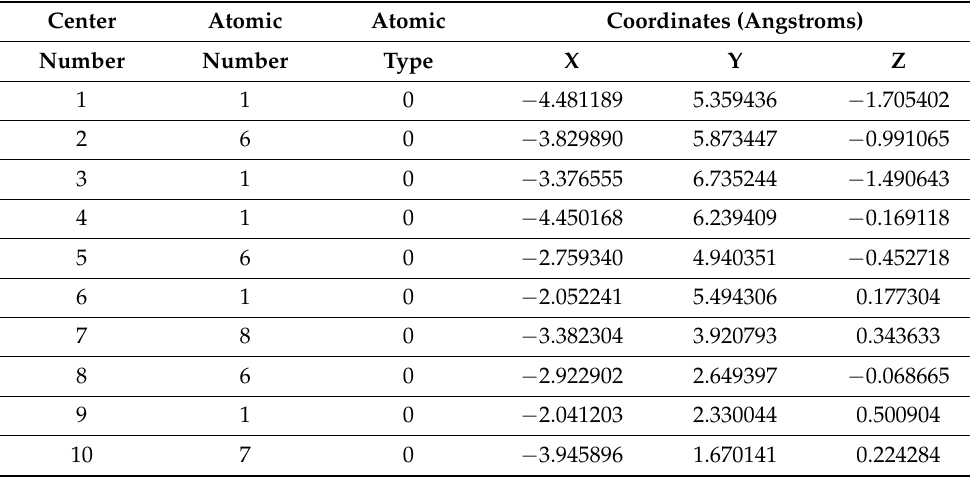
Table A8. Complex LiI 3 with nucleotide triplet GGG. Standard